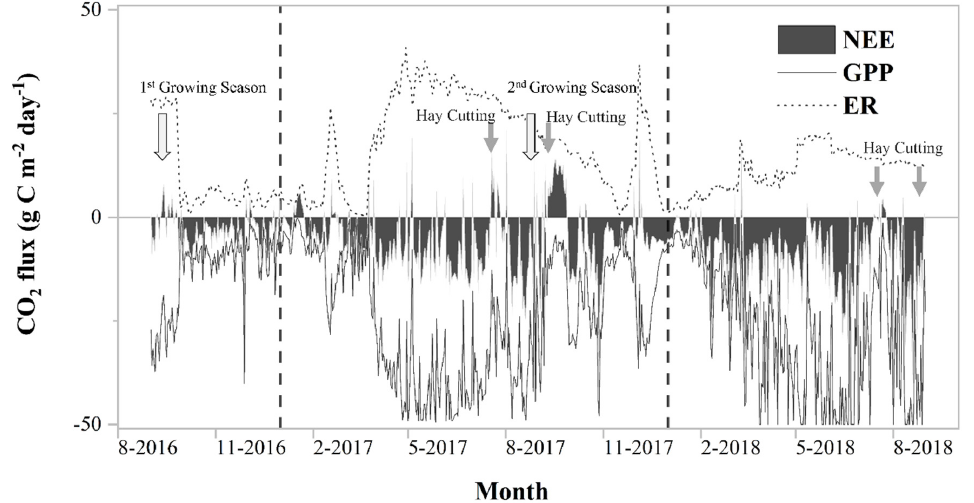
Figure 4. Thirty-minute average net ecosystem exchange (NEE) and the partitioned gross primary production (GPP) and ecosystem respiration (ER) of a cool-season grass-dominated grassland ecosystem from the 2016–2017 and 2017–2018 growing seasons located in Middle Tennessee. Dashed lines separate calendar years from each other. The daily maximum NEE reached up to 21.1 and 20.7 g C m − 2 for the first (early fall 2016 to late summer 2017) and second growing seasons (early fall 2017 to late summer 2018), respectively; and the minimum NEE reached up to − 33.5 and –43.6, g C m − 2 , re- spectively. The seasonal average daily NEE was − 5.2 and − 7.8 g C m − 2 . Large fluctuation was observed in daily cumulative GPP, with the average values of − 21.7 and − 23.9, maximum values of − 0.02 and − 0.37, and minimum values of − 49.3 and − 49.8 g C m − 2 , for the first and the second growing seasons, respectively. Following similar trends, the av- erage, maximum, and minimum ER values were 16.5, 41.3, and 0.07 g C m − 2 , respectively, for the first growing season; and 11.8, 36.9, and 0.61 g C m − 2 , respectively, for the second growing season. The seasonal cumulative NEE, GPP, and ER were − 1.23, − 3.46, and 2.23 kg C m − 2 , respectively, for the first growing season; and − 1.95, − 2.98, and 1.03 kg C m − 2 , respectively, for the second growing season. Again, the negative signs indicate carbon fluxes from the atmosphere into the ecosystem and vice versa. 3.2. Evapotranspiration Figure 5 depicts the changes of daily ET of the ecosystem. Average daily ET during the first growing season (1 September 2016 to 31 August 2017) and the second growing season (1 September 2017 to 31 August 2018) was 2.0, and 2.1 mm day − 1 , respectively. The greatest ET values were observed on 20 June 2017 (5.7 mm day − 1 ) and 7 June 2018(5.5 mm day − 1 ). The cumulative seasonal ET was 735.8 and 796.8 mm for the first and the second growing seasons, respectively. We regressed the monthly cumulative GPP with ET based on a simple linear regression, yielding a linear model (R 2 = 0.57, p- value < 0.01) with a slope of 6.48 (average EWUE = 6.48 g C kg − 1 ) and an intercept of 139.8 g C m − 2 .